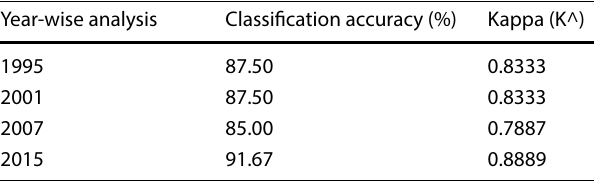
Table 1 Accuracy assessment of supervised classification